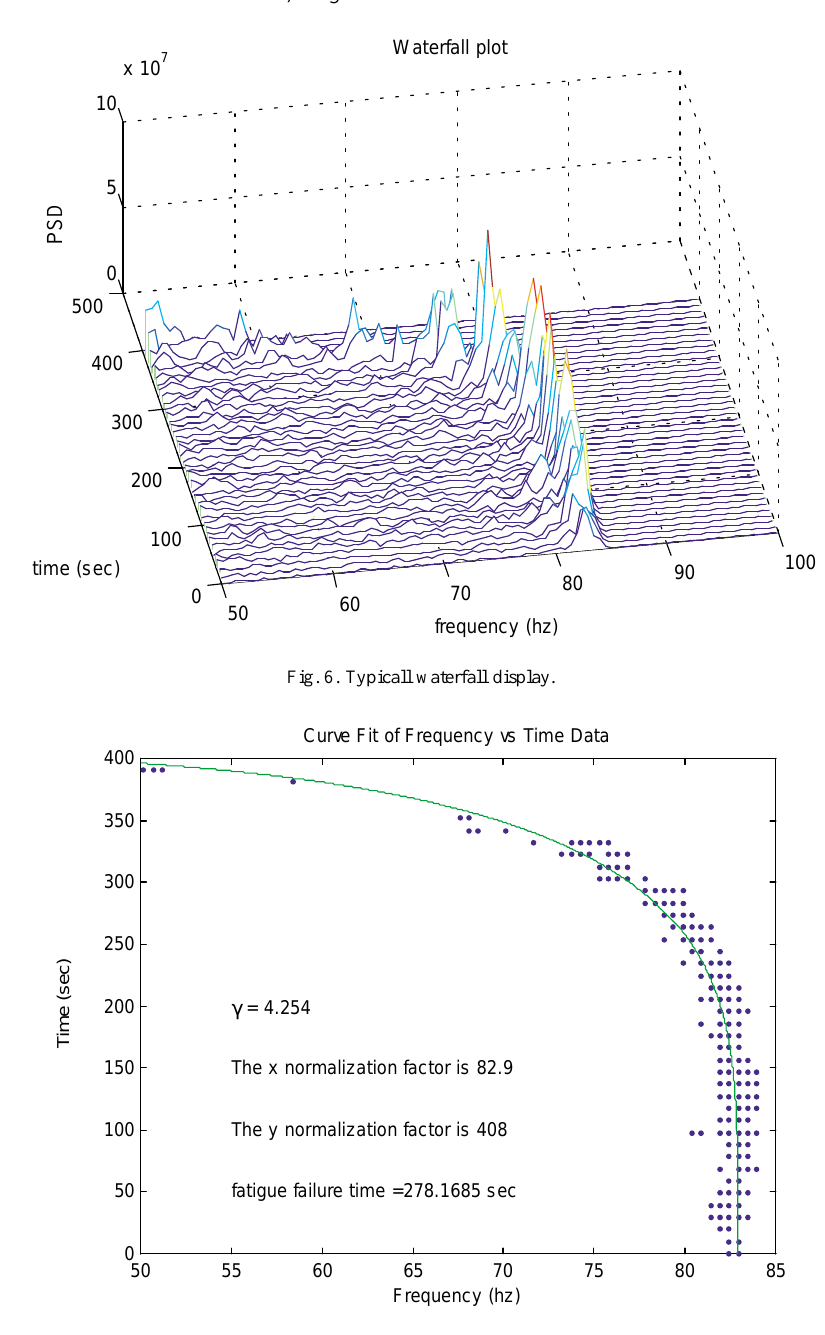
Fig. 7. Curve fit of frequency versus time